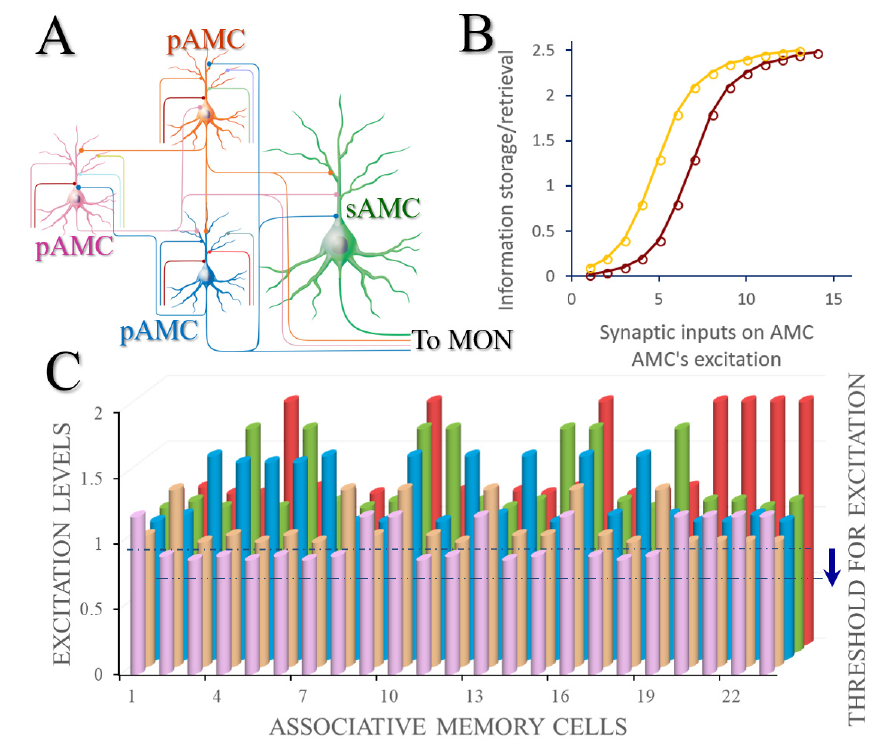
Figure 3. Associative memory cells and their functional states play the critical role in the integrative storage and the reciprocal retrieval of specific associated signals. A ) A basic neural circuit (memory trace) for associative memory includes primary associative memory cells (pAMC) and secondary associative memory cells (sAMC). Each of these primary associative memory cells receives synapse innervations from the innate inputs (their colors correspondent to those of the cell bodies), the input from the arousal system (dark red) as well as the mutual synapse innervations among them (i.e., from other primary associative memory cells). These primary associative memory cells send their axons convergently to secondary associative memory cells (green) and make synapse innervations. All of these associative memory cells send their axons to memory output neurons (MON). B ) The relationships between the excitation state of associative memory cells and the strength of memory formation/retrievals. The excitation state of such associative memory cells is influenced by the number and the function state of their synapse inputs and by their own excitability. If the excitability of associative memory cells rises, their relationship curve (dark red) shifts towards the left (yellow) and the efficiency of learning and memory increases. C ) denotes the relationship between different associative memory cells and their excitation levels. If the threshold to fire spikes (excitation) decreases, the relative excitation levels of associative memory cells increase, as well as more neurons will be coactivated for the recruitment and refinement of associative memory cells in memory formation and